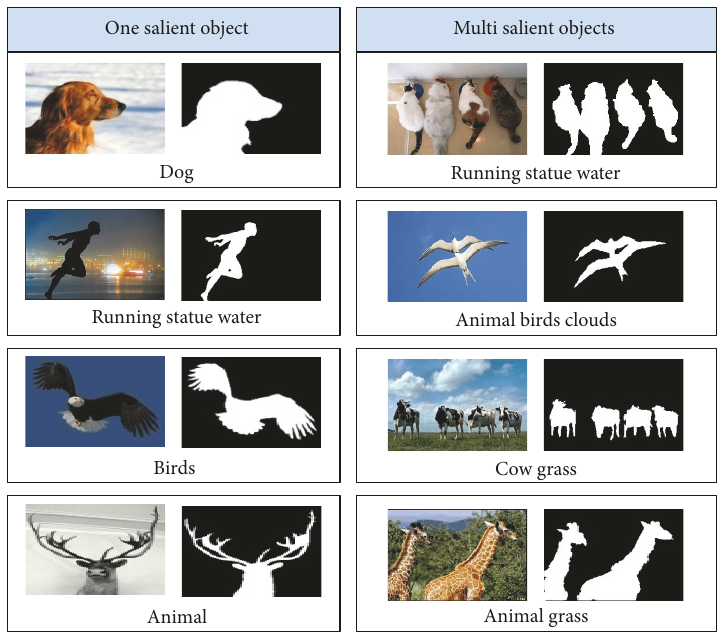
Figure 8: Images with one or multiple salient